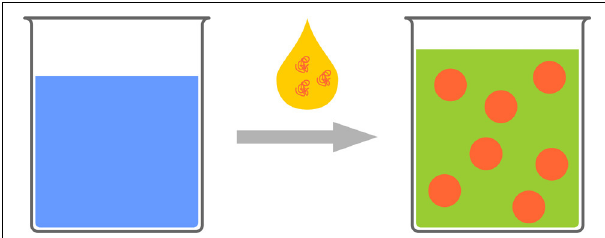
FIGURE 5 | Schematic representation of the polymeric Ouzo-effect. A polymeric solution is added to water. Nanophaseseparation leads to polymeric